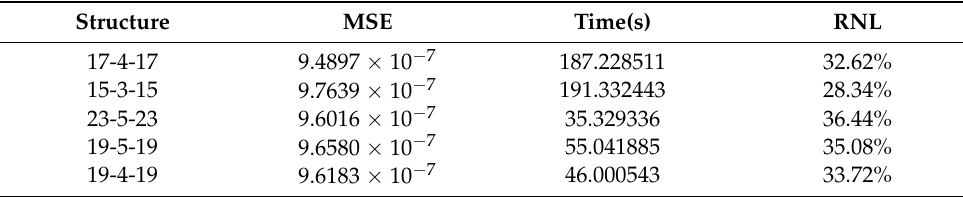
Table 3. Training results of the different network